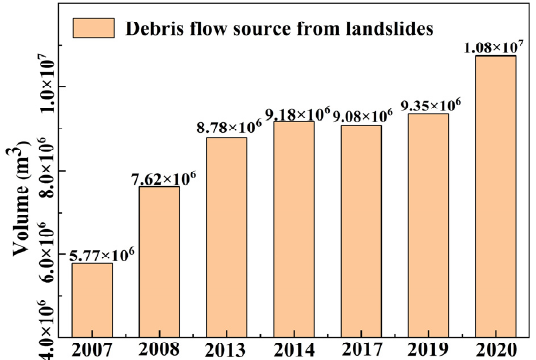
Figure 18. Contribution of landslide sediment to debris flow.